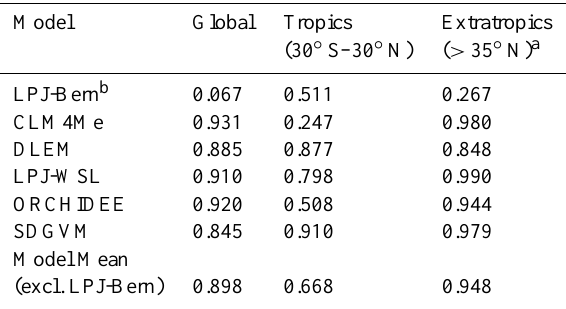
Table 4. Spearman correlation coefficients ( ρ ) for monthly wetland area and CH 4 emissions over the period 1993–2004 (see Figure 7). The model mean excludes LPJ-Bern due to its wet mineral soils